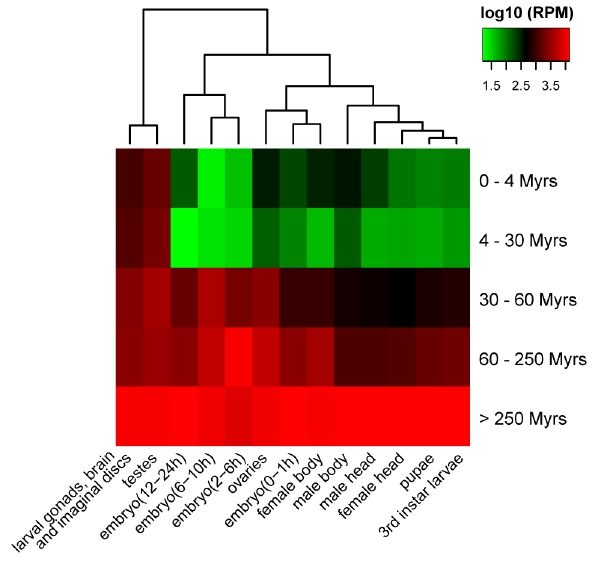
Figure 5. Clustering of miRNA expression among different age groups and tissues (or development stages). Expression level of each miRNA age group is calculated based on small RNA libraries from different tissues and developmental stages of D. melanogaster ( Table S1 ).